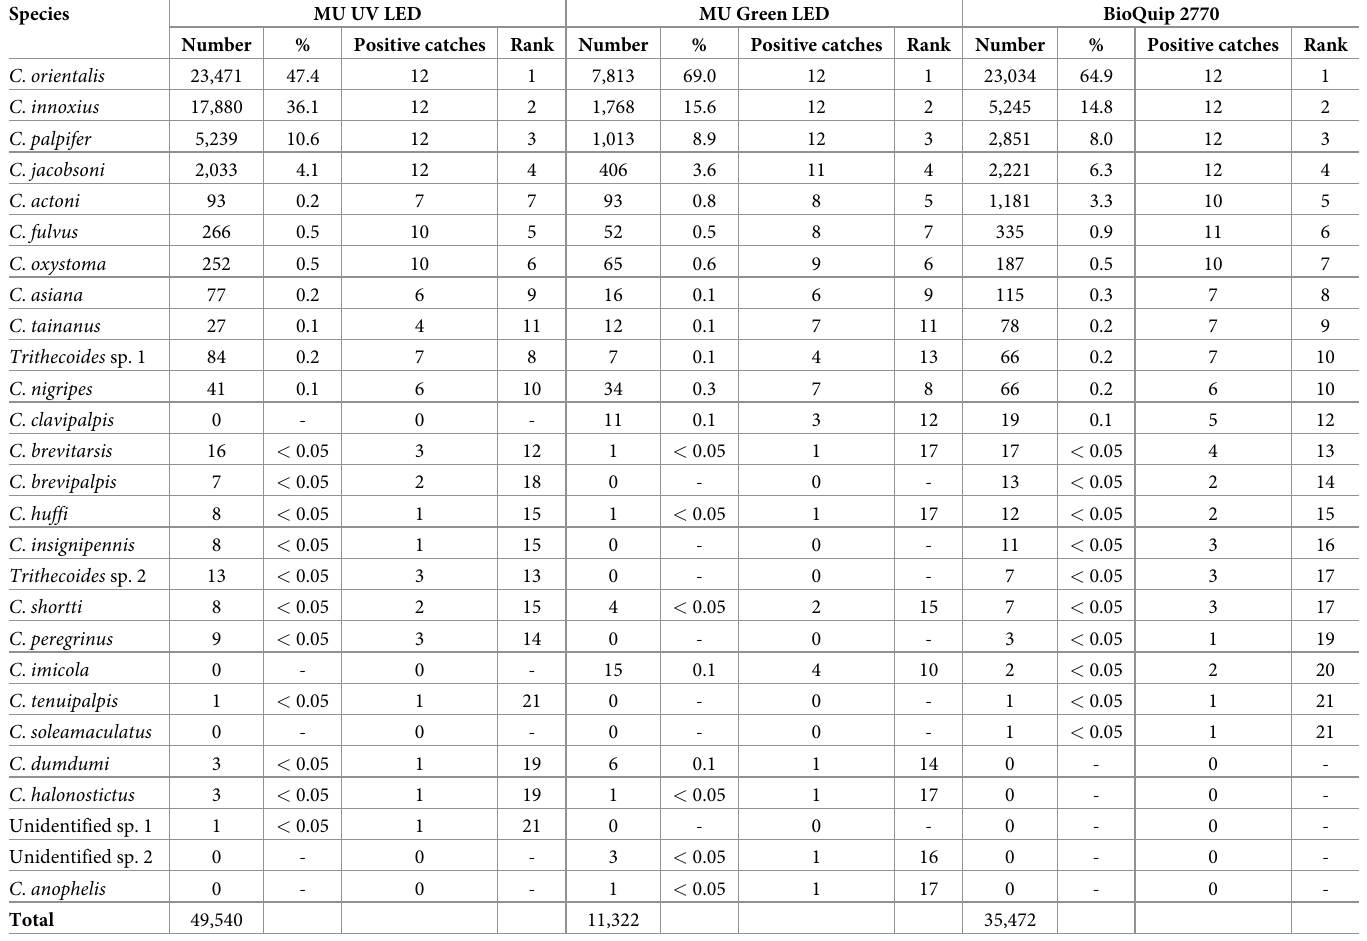
Table 4. Summary of Culicoides species collected with three different LED light traps over 12 nights between 26th July and 7th August 2020 in Sai Yok District, Kanchanaburi Province, Thailand.